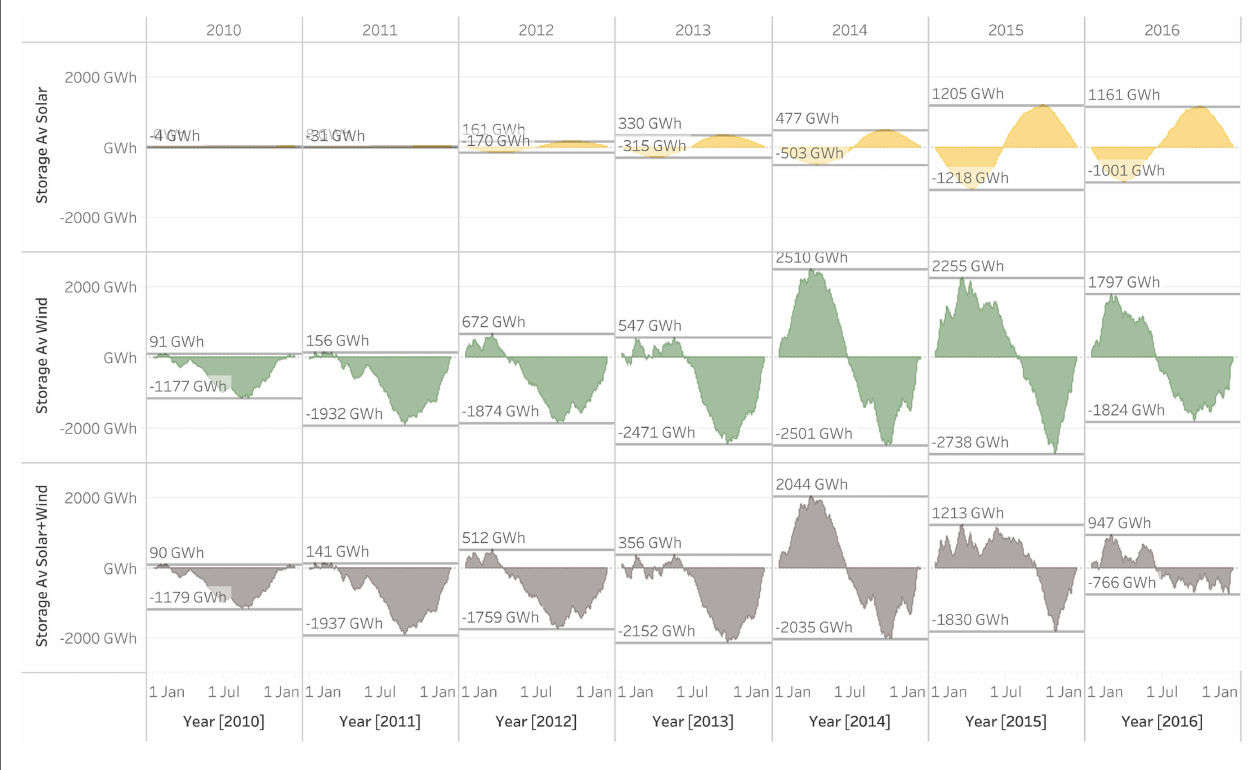
FiGUre 3 | Cumulative difference between Great Britain daily and average annual output from solar, wind, and solar +